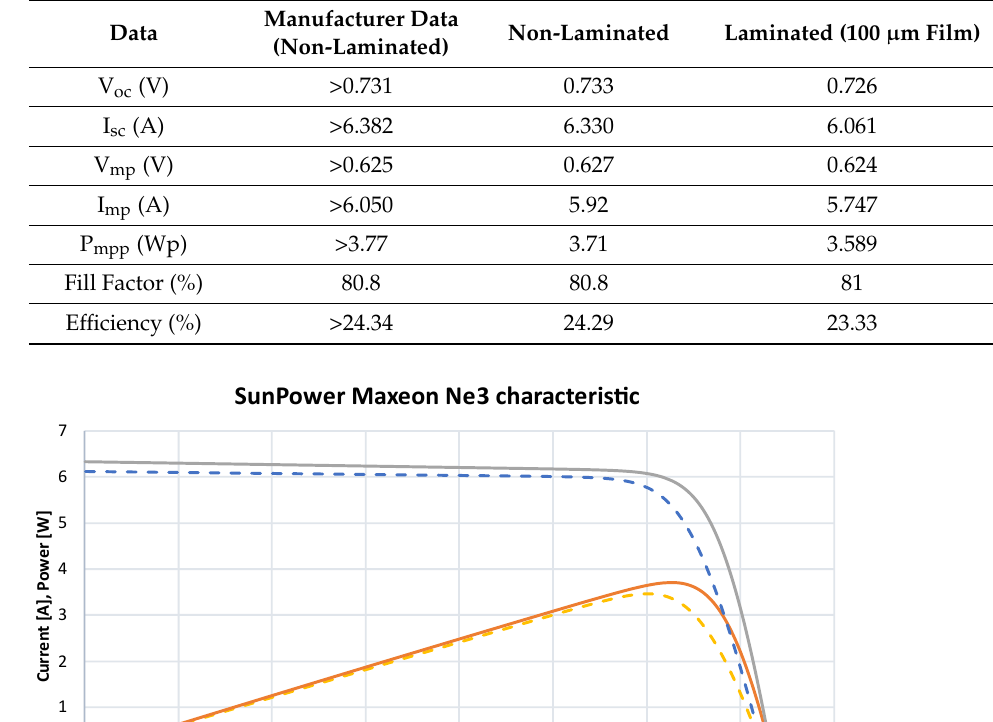
Figure 8. Topography of the electric contact surfaces of a monocrystalline silicon photovoltaic cell of the N-type: ( a ) contact of fingers (grid lines) with connectors; ( b ) finger (grid line).